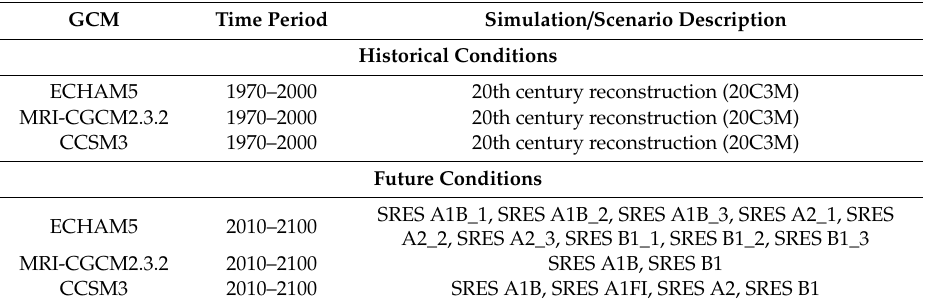
Table 1. Summary of the Climate Projections Dynamically Downscaled Over Peninsular